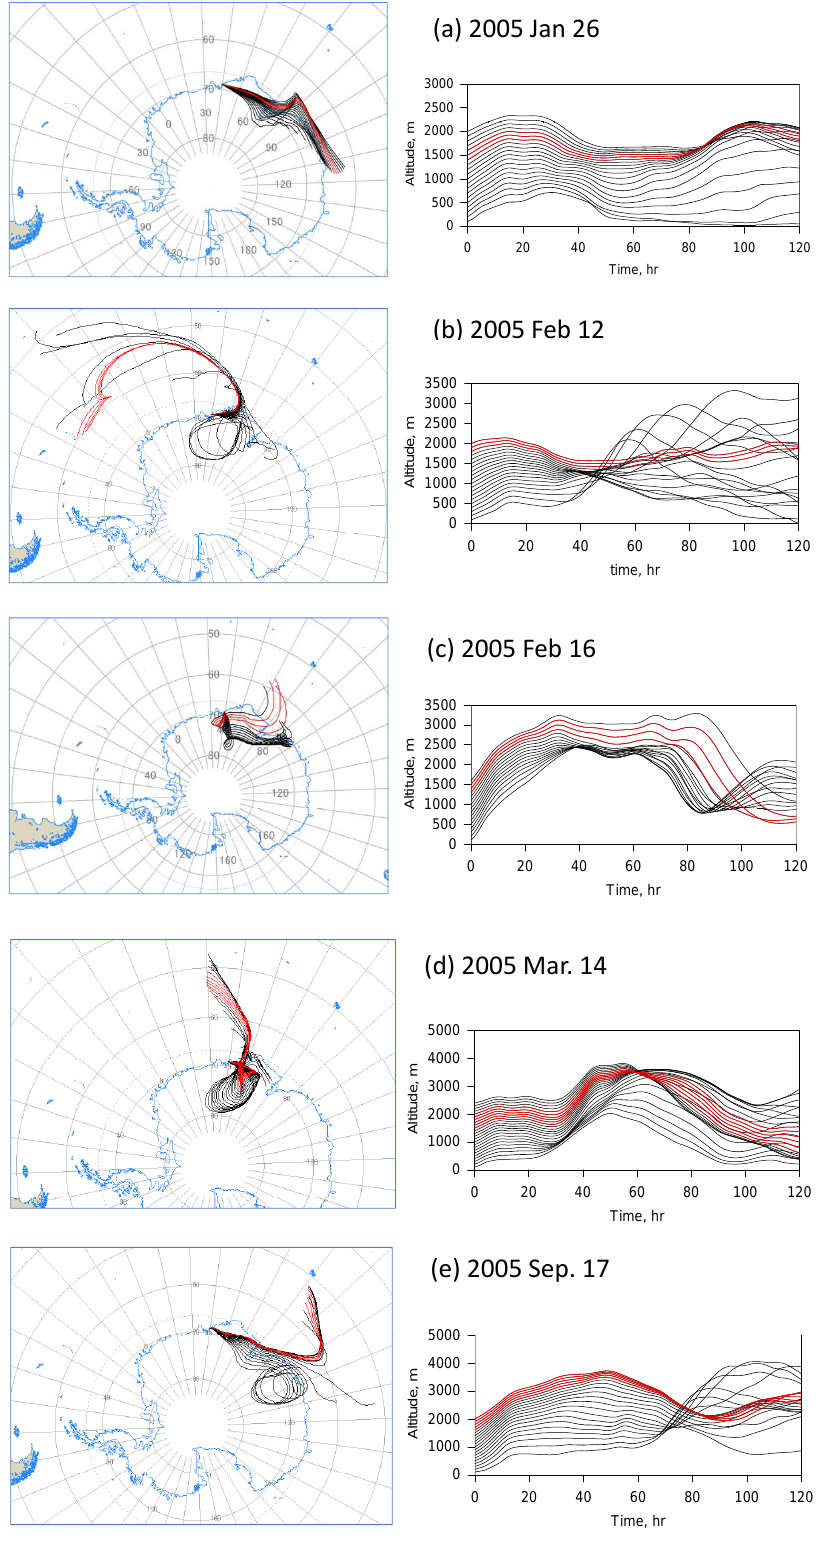
Fig. 6. 5-day backward trajectory in appearance of CN-enhanced layer: (a) 26 January, 2005, (b) 12 February, (c) 16 February, (d) 14 March, and (e) 17 September. Red lines represent the trajectory from CN-enhanced